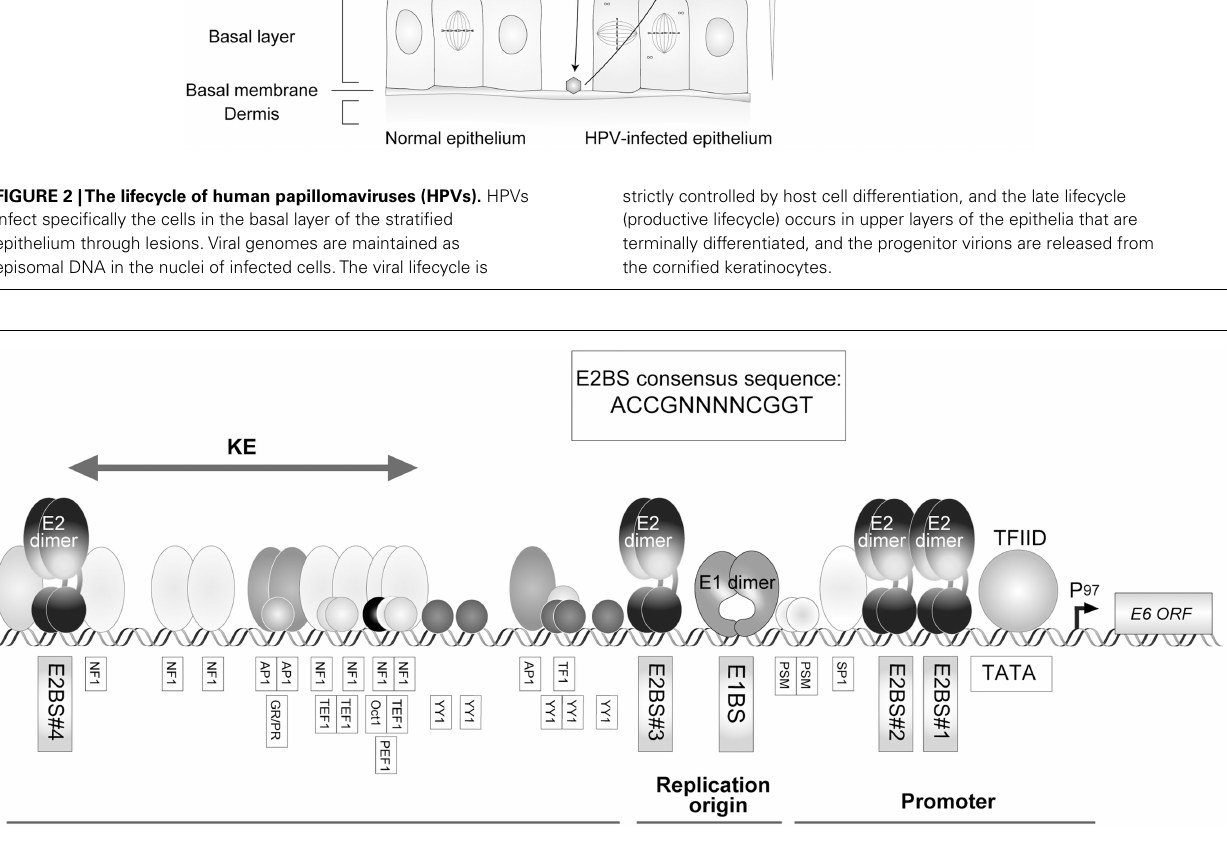
in HPV16 LCR and the consensus sequence for E2BS is shown in an inset. A glucocorticoid receptor and progesterone receptor (GR/PR) recognition element was also identified in the LCR.The existence of a keratinocyte-specific enhancer (KE) has been proposed (Desaintes and Demeret,